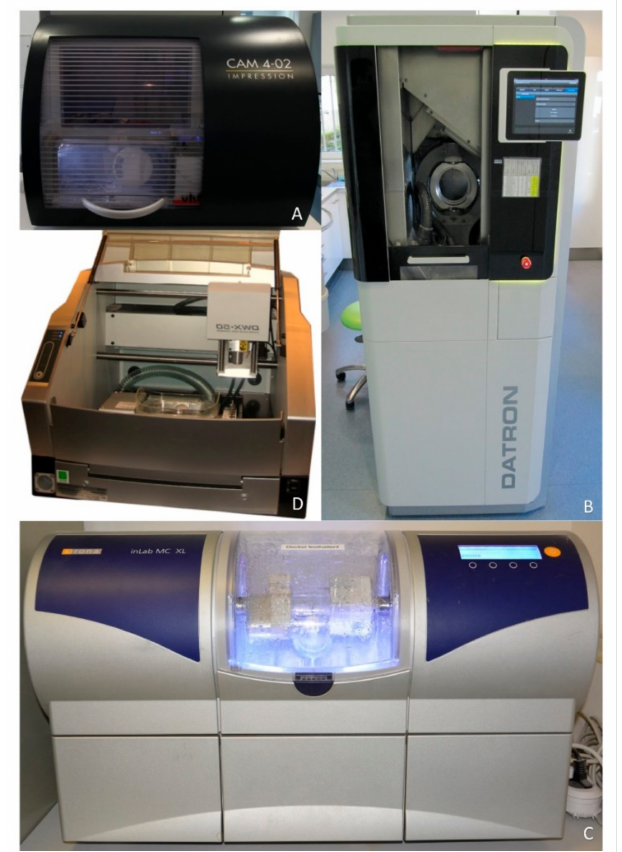
Figure 2. CAM Systems. System ( A ) (VHF CAM 4-02 Impression), system ( B ) (Datron D5), system ( C ) (Cerec MCXL) and system ( D ) (Roland